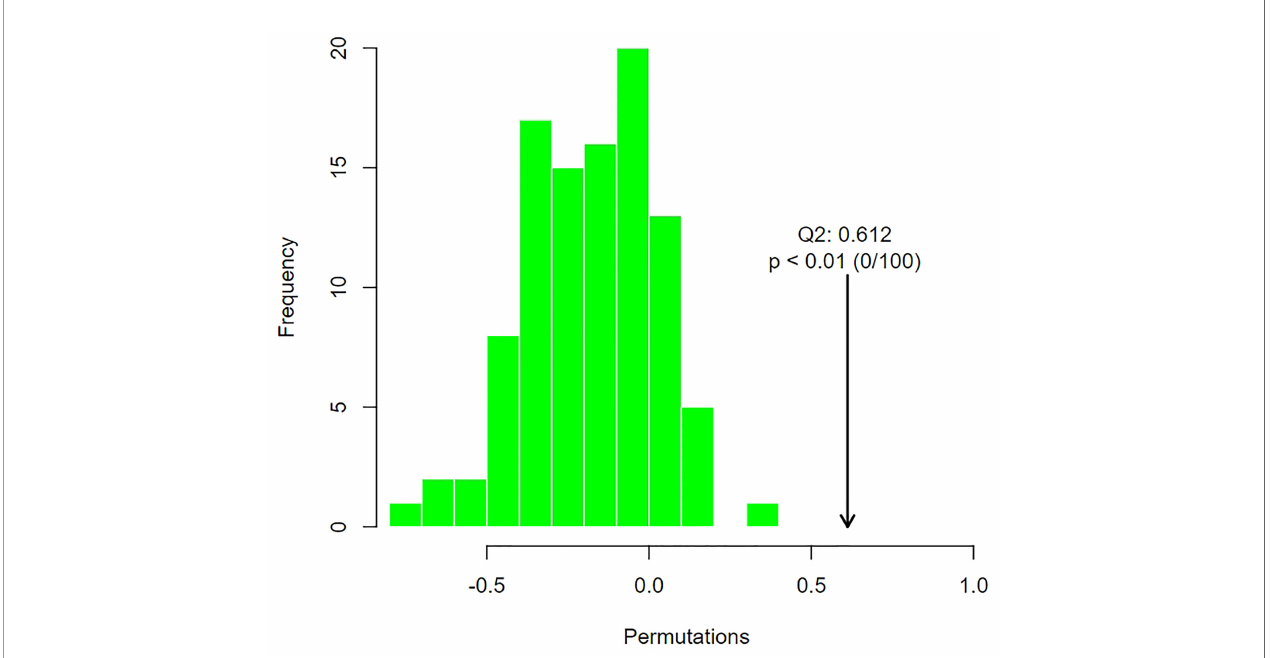
FIGURE 7 | Distribution of test statistics (Q 2 ) and P value of OPLS-DA permutation test of group of POR and controls. The distribution diagram is the permutation random distribution of Q 2 , and the arrow refers to the actually observed model Q 2